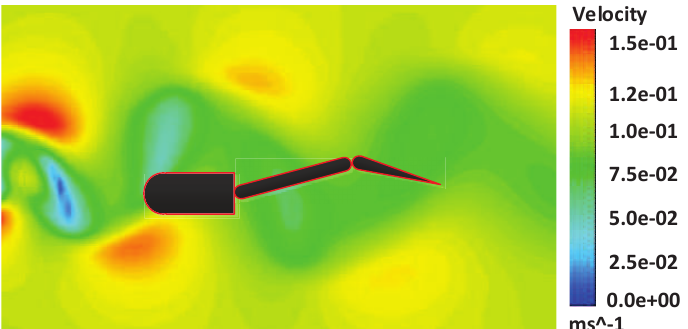
Figure 12. The robotic fish in Karman vortex.